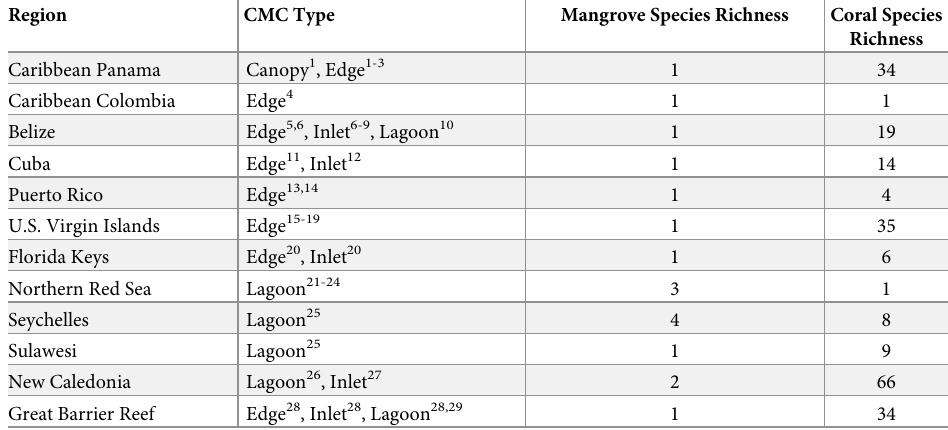
A list of mangrove and coral species by region, study, and CMC type is provided in S1 Table. Coexisting mangrove-coral (CMC) habitats reported in existing literature and our study, indicating location of observations, type of CMC habitat, number of mangrove species corals were found growing within, number of coral species observed, and the source from which the information was obtained.